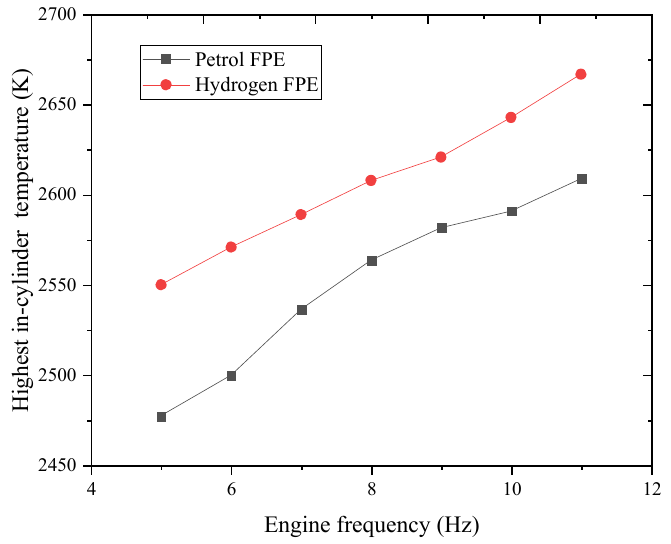
Figure 13. NOx emission comparison between three models.